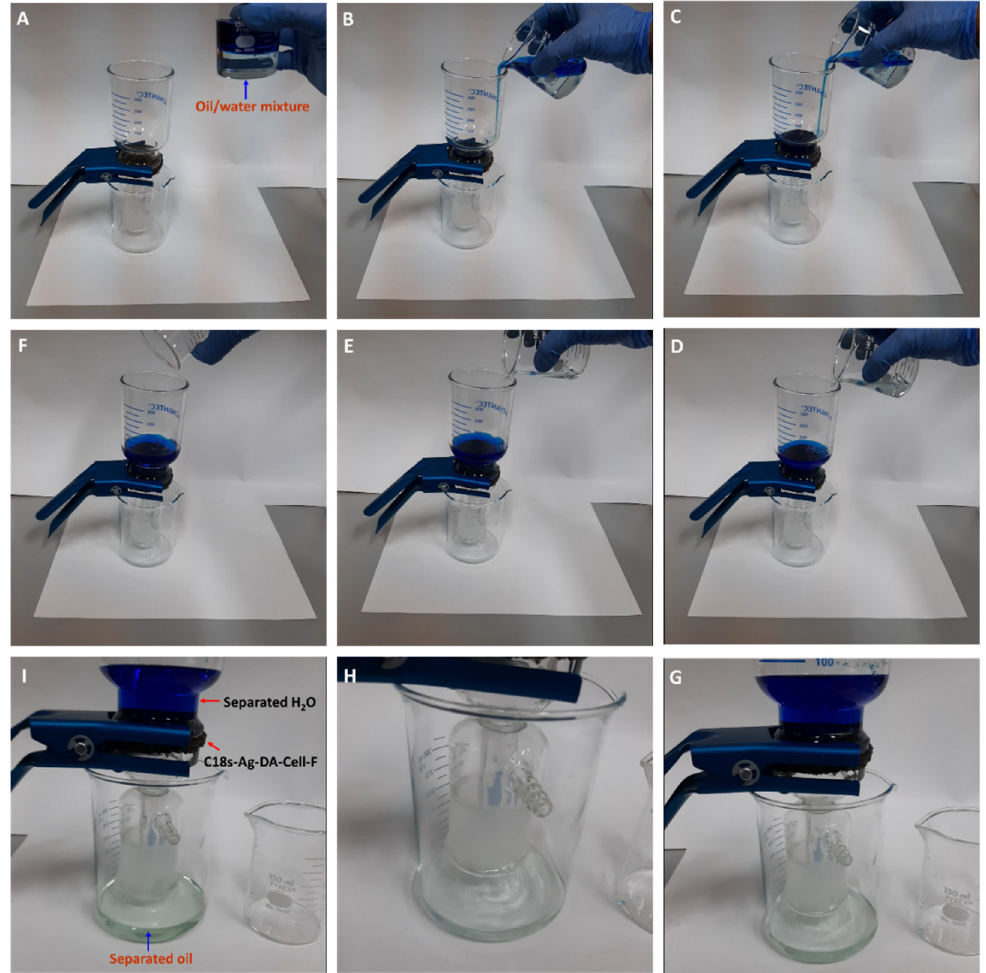
Figure 6. Illustration of the separation of oil and water mixture by using the C18s-Ag-DA-Cell-F. “ A ” indicates the starting point and “ I ” is the complete separation of the oil and water mixture.